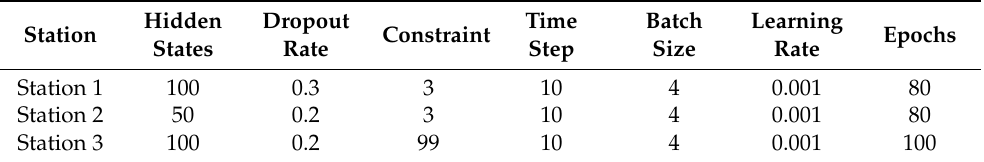
Table 6. Hyperparameters with the lowest error score for the flow rate model selected by a 5-fold cross validation grid search.